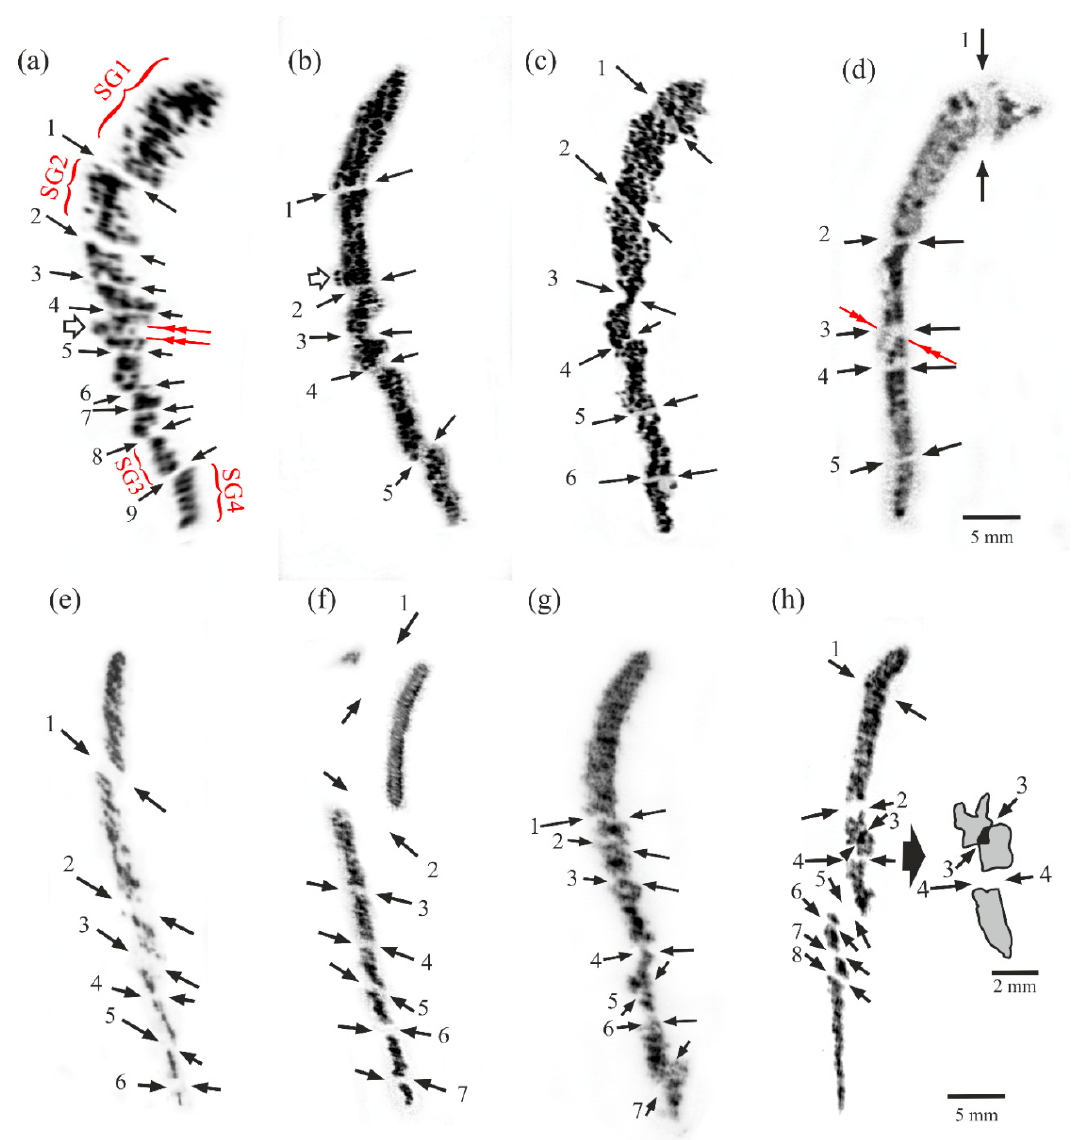
Figure 2. X-ray topograms obtained from micro-section III of an airfoil of I-series ( a – d ) and II-series ( e – h ) obtained at a withdrawal rate of 2 mm/min ( a , e ), 3 mm/min ( b , f ), 4 mm/min ( c , g ) and 5 mm/min ( d , h ). Reflection 113. CuK α radiation.